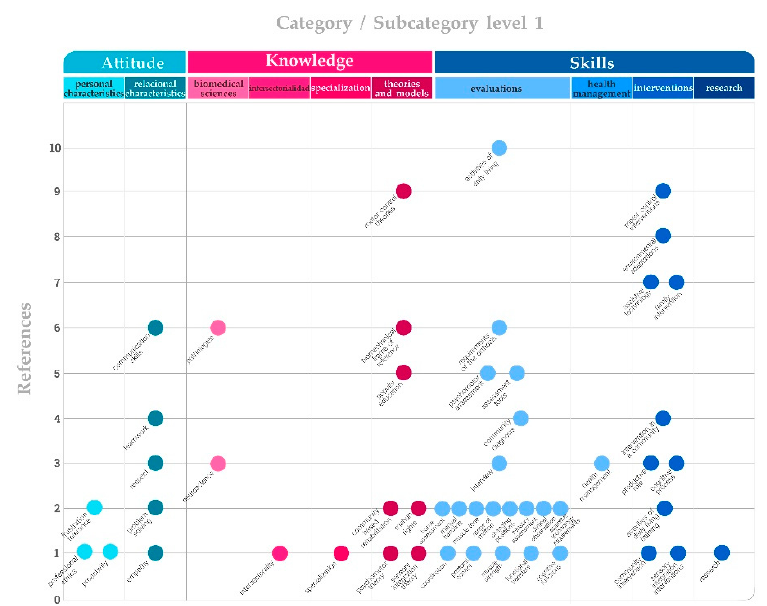
Figure 4. Diagram of code references. Each circle represents a code associated with ten subcategory levels, which are linked to the three major categories: attitude, knowledge and skill.